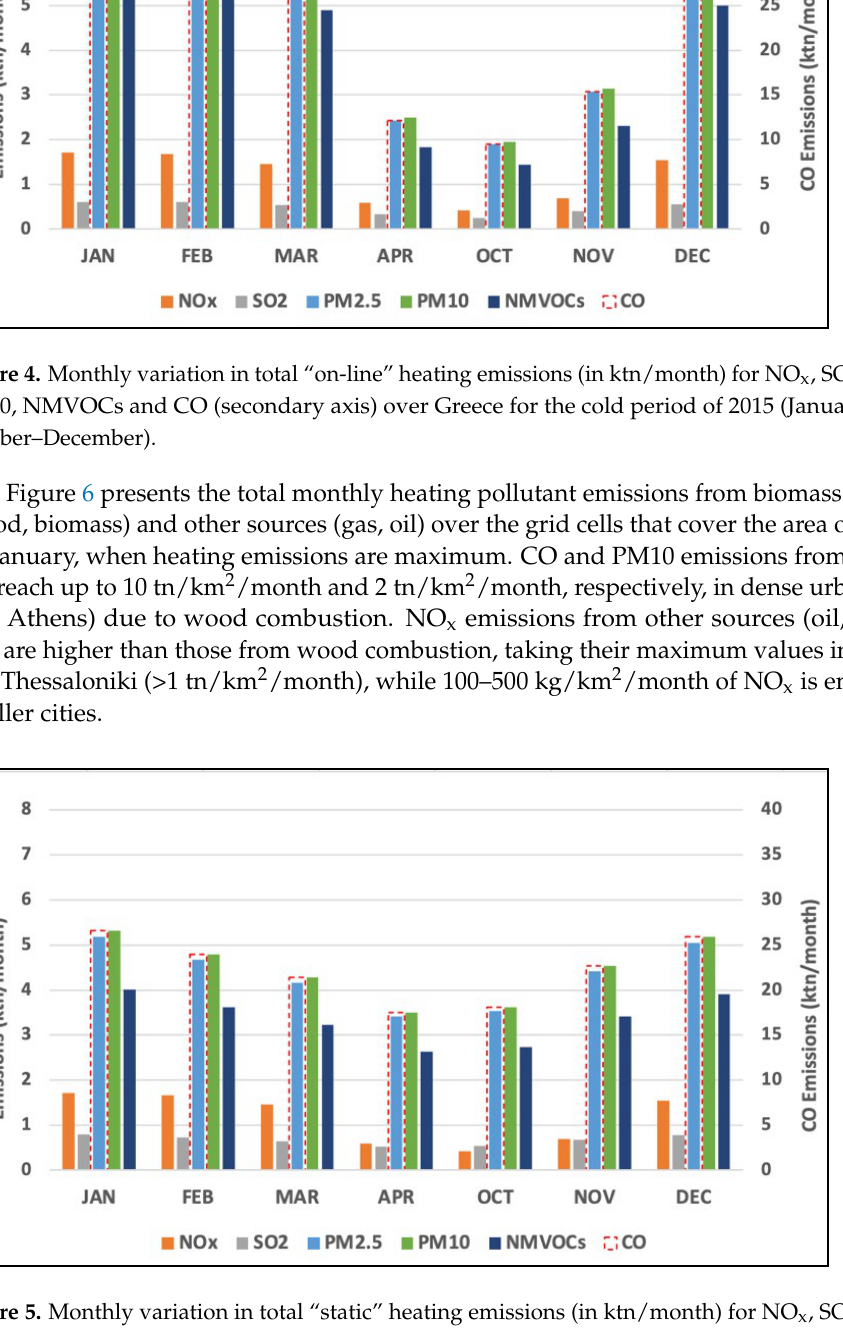
Figure 5. Monthly variation in total “static” heating emissions (in ktn/month) for NO x , SO 2 , PM2.5, PM10, NMVOCs and CO (secondary axis) over Greece for the cold period of 2015 (January–April, October–December).